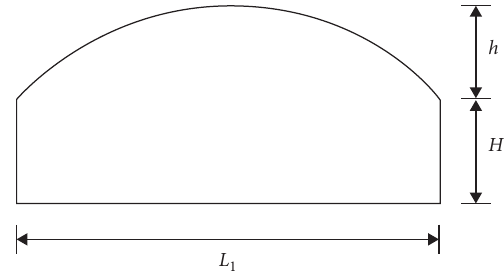
Figure 8: Model of the spherical shell roof.